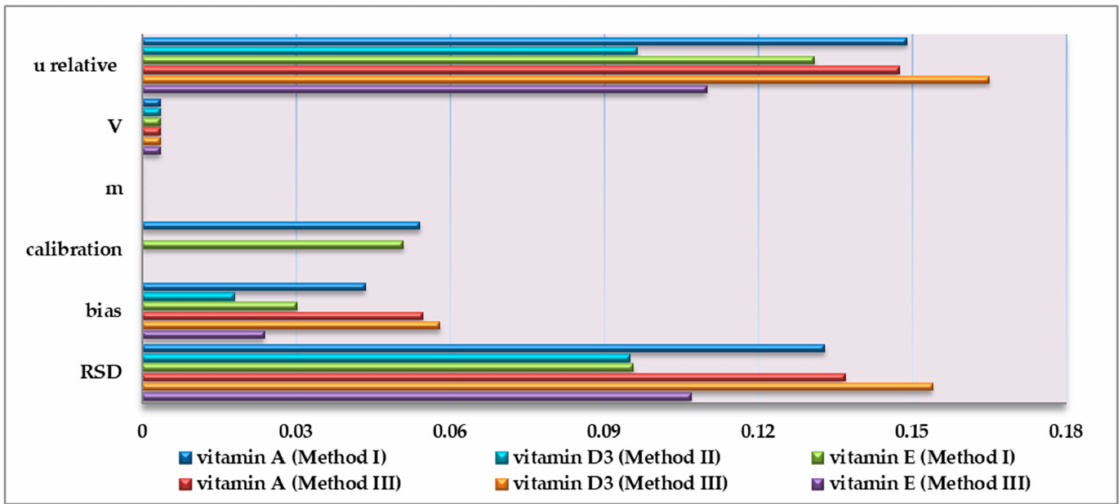
Figure 3. Uncertainty contribution (u relative) in the medium fortification level for all the vitamins taking into